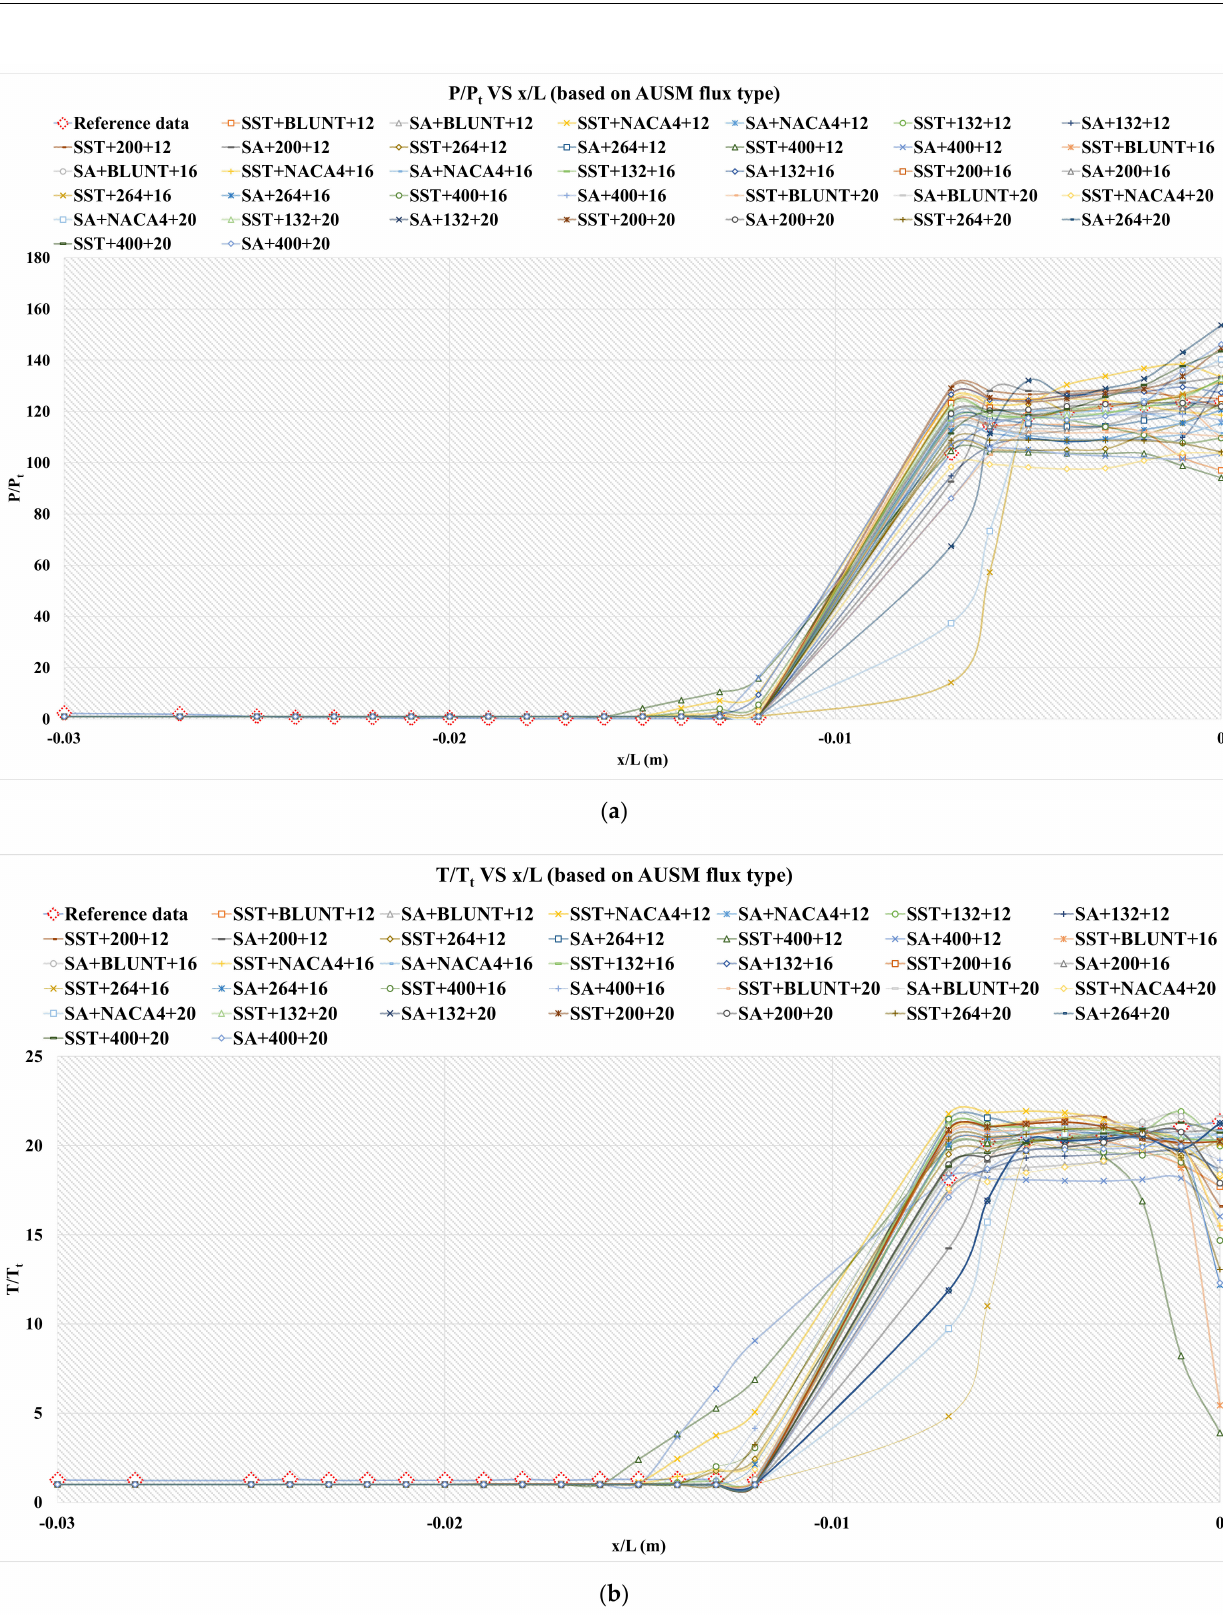
Figure 35. ( a ) Distributions of P/P t of AUSM flux type; ( b ) Distributions of T/T t of AUSM flux